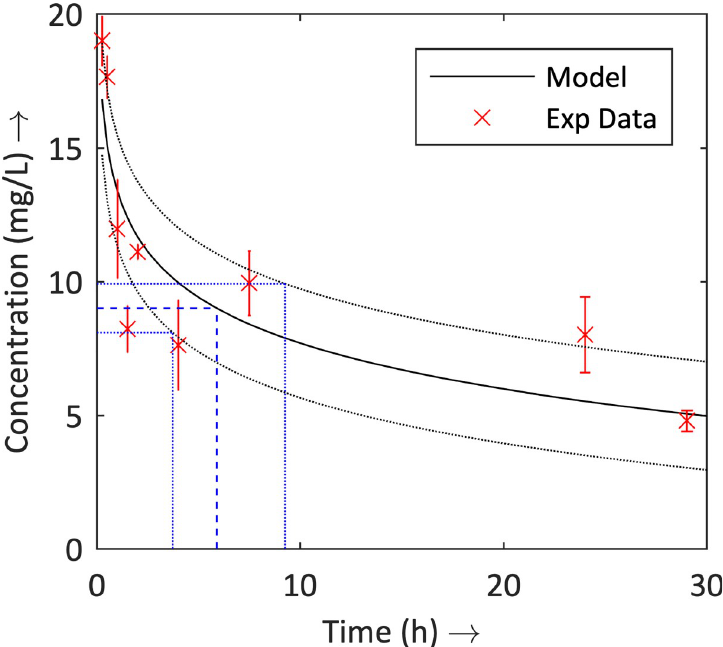
Fig 1. Decay rate of the antibiotic (TET) over time in G . mellonella host. Biological data of the decay rate of the antibiotic over time in G . mellonella (red points); and fitted curves for the experimental data (black lines) and the estimate for the half-life of the antibiotic (blue lines). The black and blue dotted lines represent the respective 95% confidence intervals.